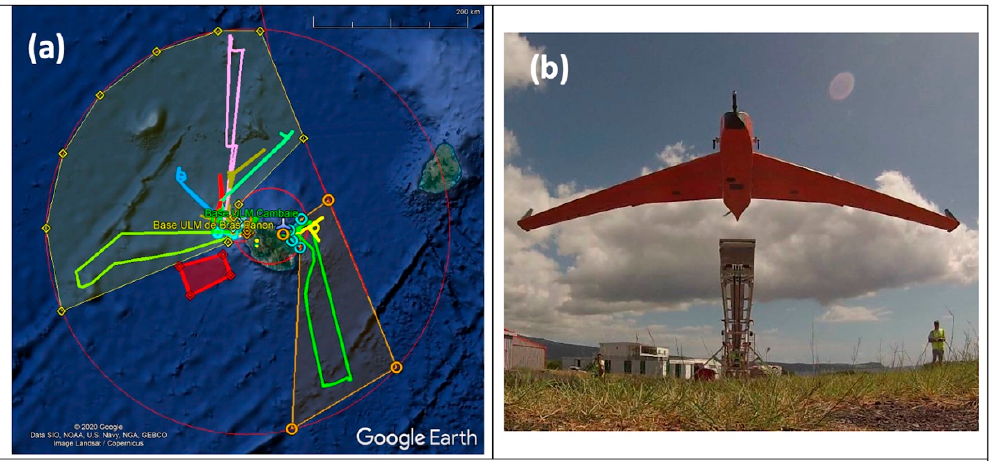
Figure 15. ( a ) The 12 BOREAL flights operated from Réunion Island during the RNR-CYC campaign in February and March 2019. The yellow and orange polygons represent the authorized flight zones to the northwest and southeast of Réunion Island. The outer red circle denotes an operating radius of 250 km around Réunion Island. ( b ) The BOREAL UAS leaving the catapult for a scientific mission from Cambaie, Réunion Island. Sources: (a) Google Earth; (b) Greg Roberts